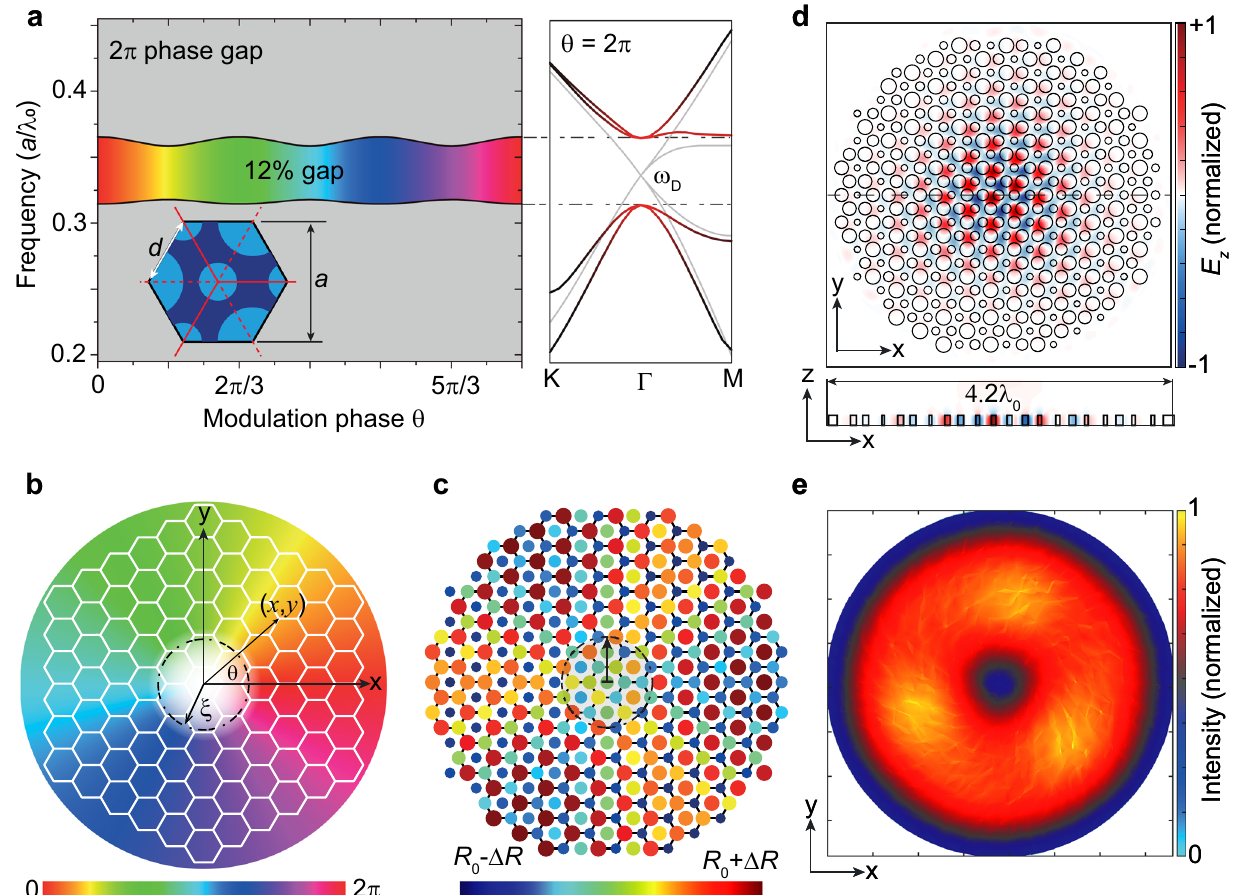
Fig. 2 | Numerical simulations of the topological cavity. a Band diagram of a hexagonal supercell with a Kekulé modulation (left panel) and the unmodulated photonic crystal (right panel). The bandgap has ≥ 12% relative width. Inset: sche- matic of the hexagonal supercell and its Brillouin zone. b The phase of the Kekulé pattern, which has winding number of +1. The colorbar de fi nes the smooth phase varyingfrom0to2 π . c Modulationofthephotonicstructure ’ sair-holeradii,usinga